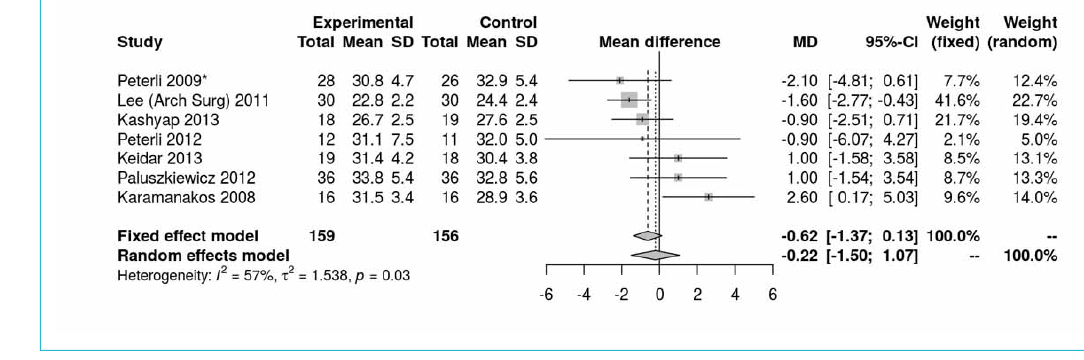
Figure 6d: Body mass index (BMI) at 12